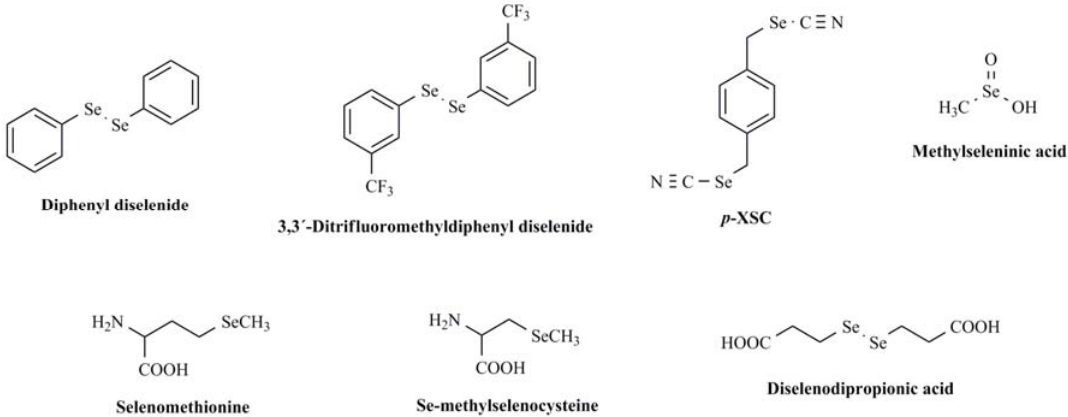
Figure 3. Chemical structures of some representative selenium compounds with antioxidant properties.